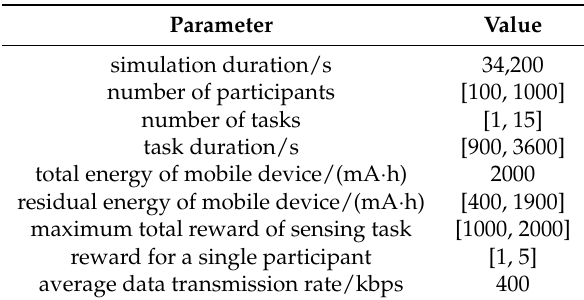
Table 1. Simulation parameter